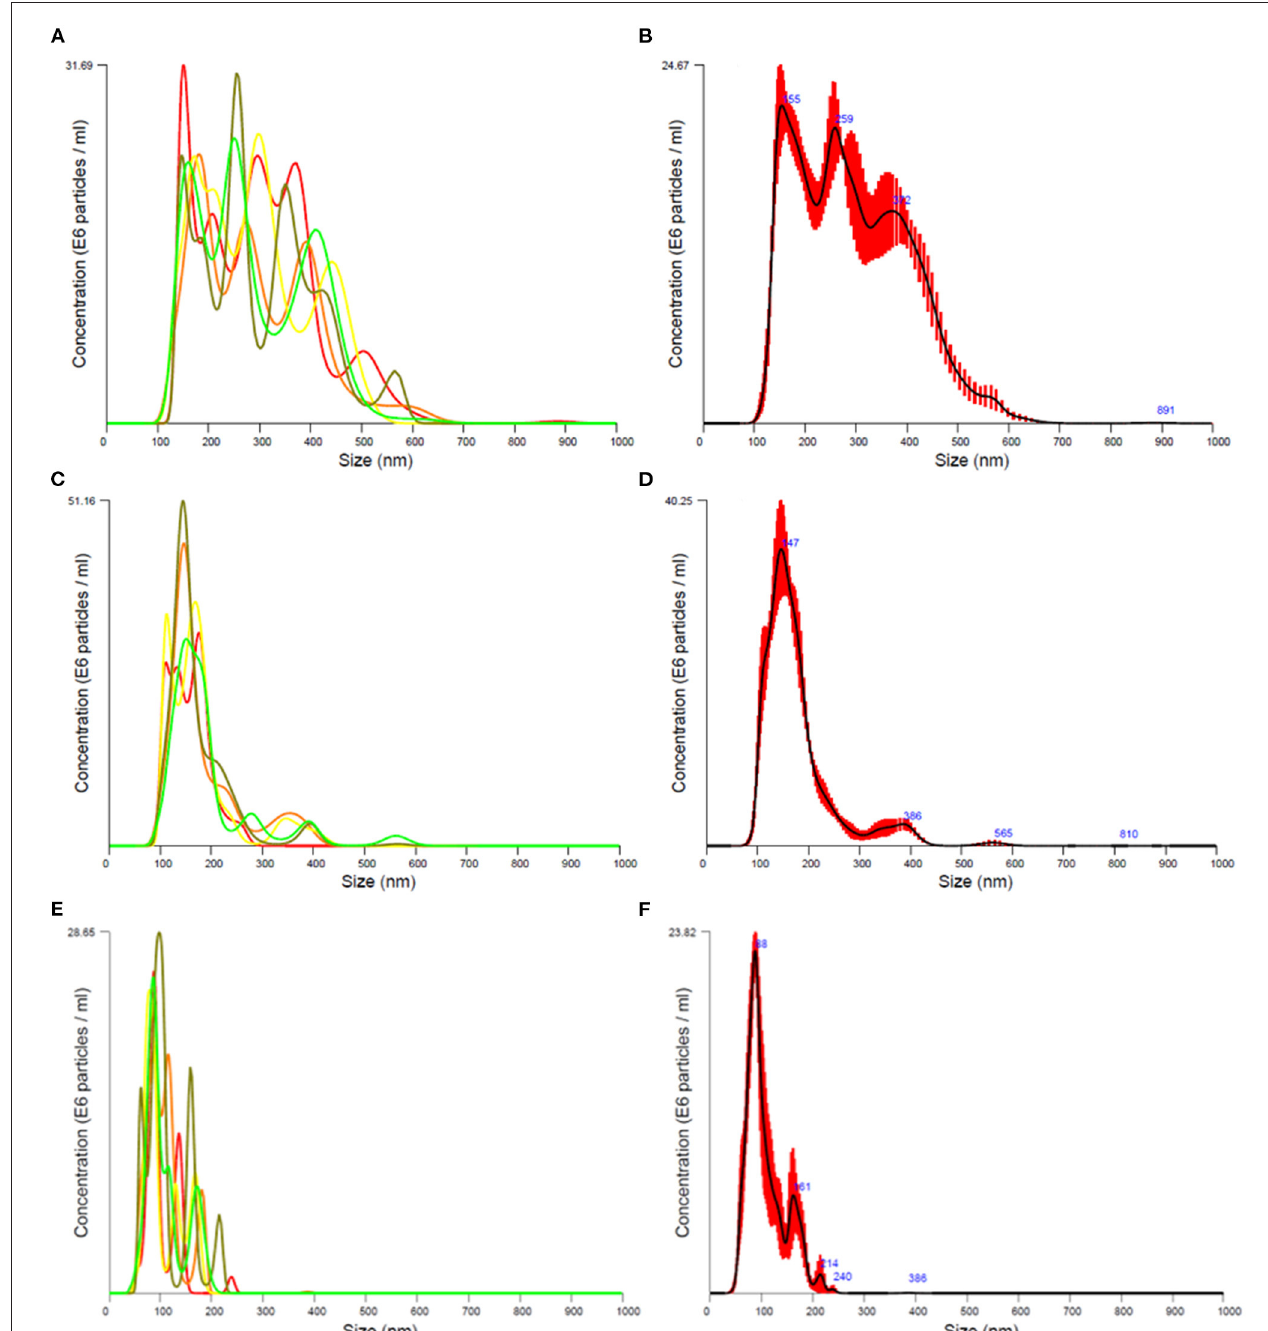
FIGURE 3 | Particle size distribution of final exposure suspensions from transparent polypropylene (A,B) and polyethylene terephthalate plastics (C,D) in the pilot study, and suspensions from black polyethylene terephthalate plastics in the main (E,F) study. The suspensions were analyzed in filtered water for injection. The mean particle size distribution (B,D,F) has been obtained from five consecutive size distribution measurements (A,C,E) .